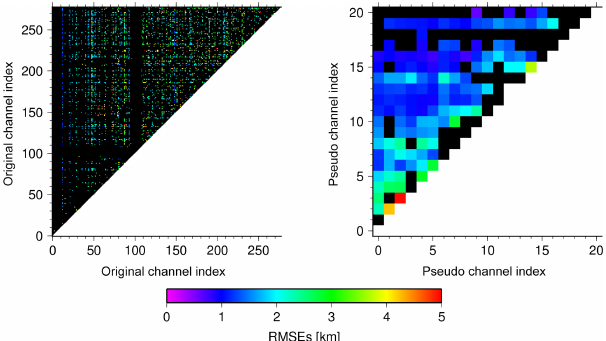
Figure 2. Weighting function profiles of reconstructed channels us- ing the midlatitude summer atmospheric profile model of Air Force Geophysics Laboratory (AFGL; left) and the number of original channels within each reconstructed channel (right).